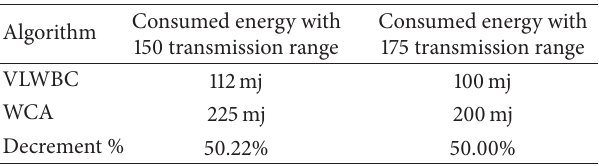
Table 4: Comparing the proposed algorithm and WCA algorithm in terms of energy